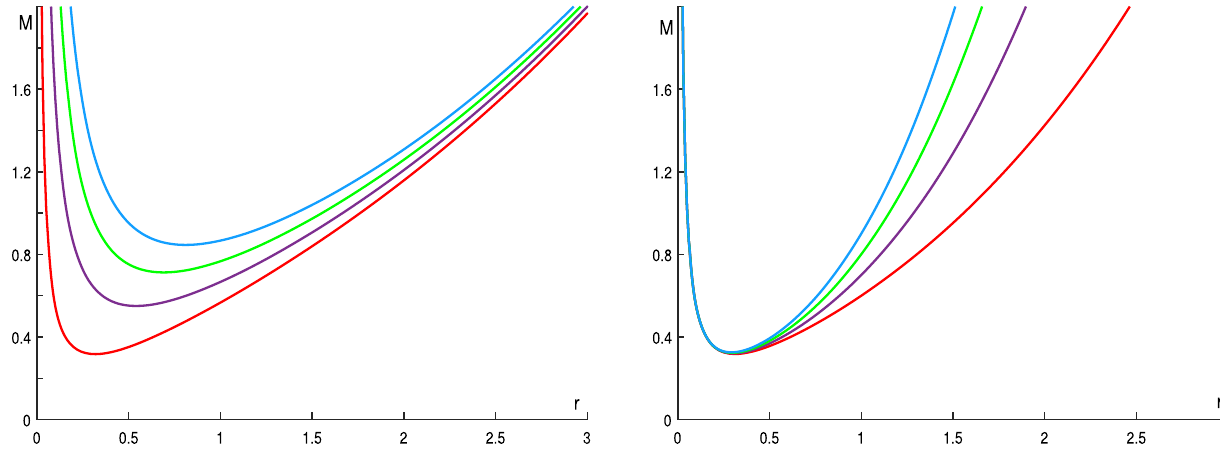
Fig. 6 The behavior of mass versus radius of AdS 4D EGB black hole. Left plot has been depicted with (cid:5) = 0 . 1 and right one with (cid:5) = 0 . 3 while α = 0 . 7 , 0 . 5 , 0 . 30 . 1 from up to down. Decreasing α decreases the minimum